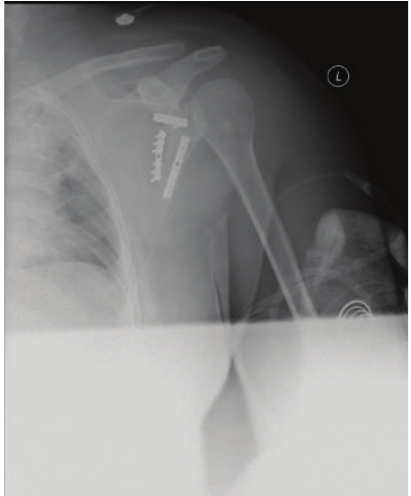
Figure 12: Postoperative anteroposterior radiograph of the left shoulder demonstrating an anatomic reduction of the scapular fracture with good positioning of the